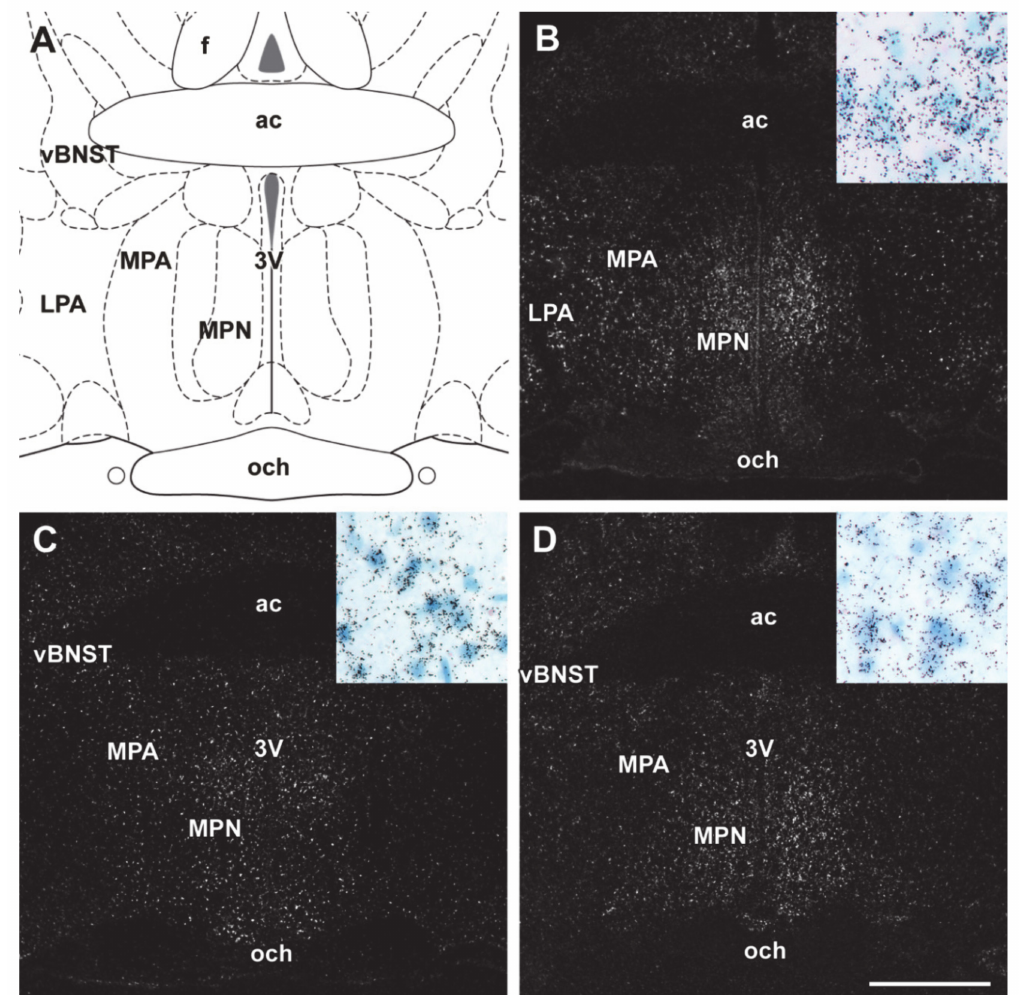
Figure 5. In situ hybridization histochemistry (ISHH) of DEGs in the preoptic area. White dots represent mRNA hybridiza- tion signal on the dark-field photomicrographs. Bright-field inlets demonstrate the autoradiography grains above labeled cells. ( A ) A drawing of the preoptic area in rat. ( B ) Ndufs5 mRNA hybridization signal was abundant in the MPN and also present in lateral preoptic area (LPA). ( C ) Nwd1 mRNA hybridization signal was seen in MPN, MPA, and also in the ventral subdivision of the bed nucleus of stria terminalis (vBNST). ( D ) Rbm3 mRNA expression was abundant in the MPN, MPA, vBNST. Scale bars =1 mm. Further abbreviations: ac—anterior commissure; och—optic chiasm; 3V—third